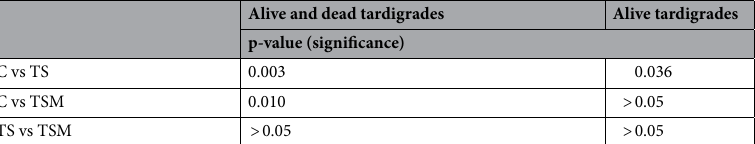
Table 2. Results of post-hoc tests (two sample rand. Tests + Holm’s correction; # of rand. = 10,000) for one- way ANOVA randomized run for transferred alive and dead tardigrades (F = 5.913, P = 0.002), as well as alive tardigrades only (F = 3.154, P = 0.0356). C control, TS snails and tardigrades, TSM snails, tardigrades and moss.